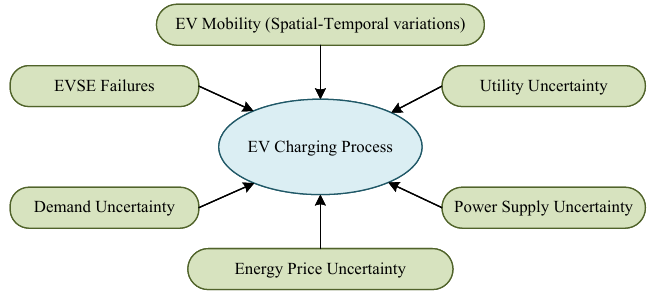
Figure 1. Uncertain aspects for EV charging process